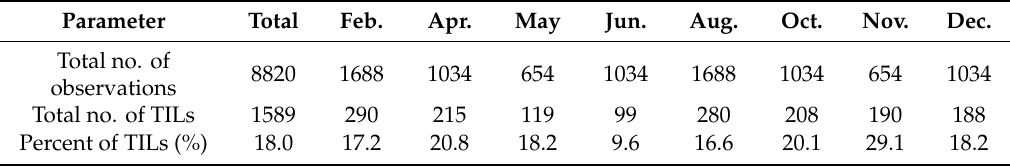
Table 2. The distribution of occurrences of TIL in the NECS during 1995 to